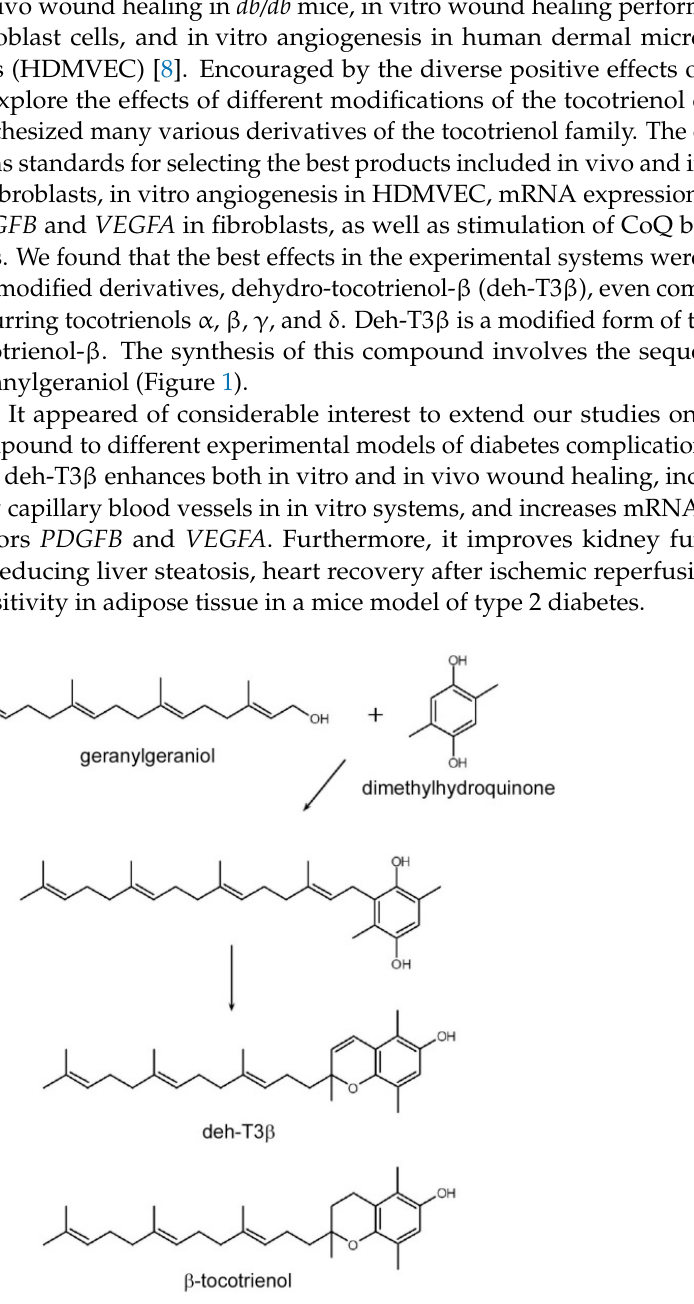
Figure 1. Structure and synthesis of dehydro-tocotrienol- β (deh-T3 β ). For comparison, the structure of the naturally occurring β -tocotrienol is shown.